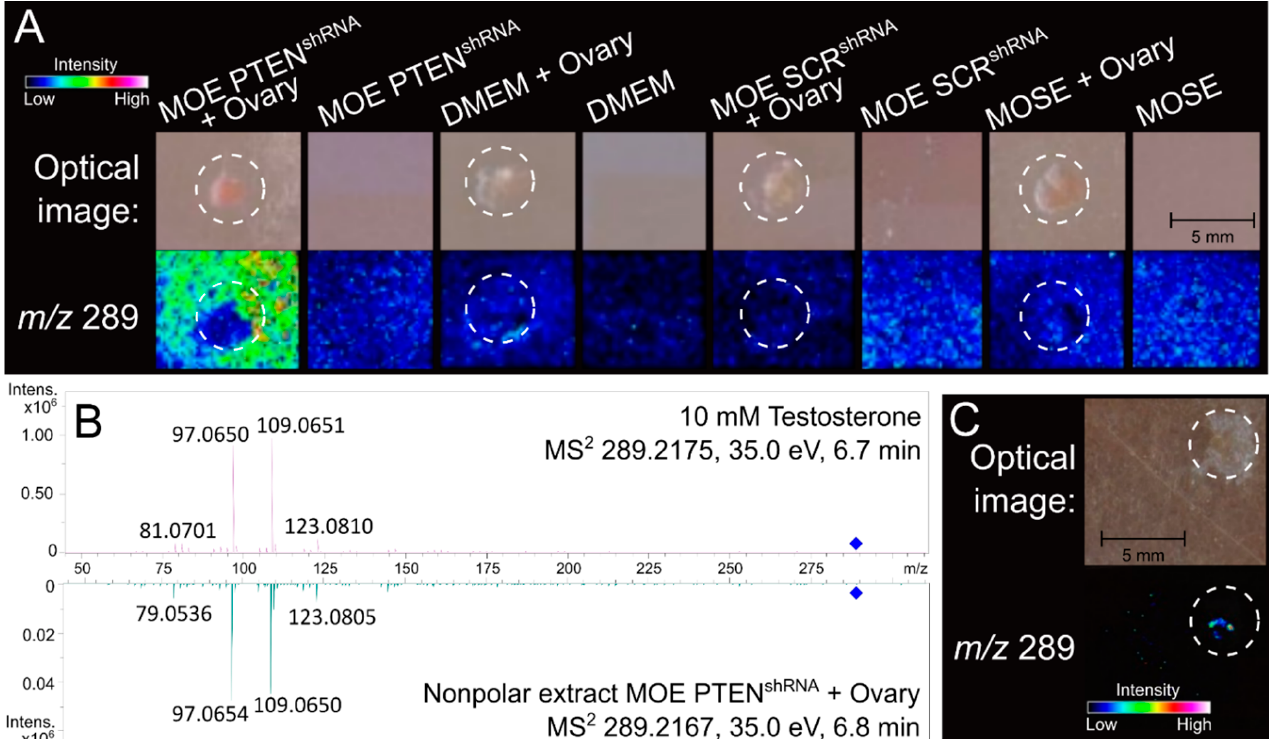
Figure 1. Tumor cells increase ovarian production of androgens. ( A ) A biomolecule upregulated in an in vitro tumorigenic condition may be testosterone. A validated imaging mass spectrometry sample preparation method was employed to detect increased production of small molecules (<2000 Da) in a condition of tumorigenic murine oviductal epithelial cells (MOE PTEN shRNA ) incubated with a healthy murine ovary, compared to seven controls. Signal detection (by nominal m/z ) was compared to MOE:SCR shRNA (MOE cells with a scrambled shRNA, used as a gene control), MOSE (murine ovarian surface epithelial cells, used as a cell control), and culture medium, DMEM. Each cell line was incubated for four days with and without an ovary (outlined by a dotted white circle). Resulting IMS data were normalized to the TIC and evaluated by the statistical software SCiLS to determine signals significantly more abundant ( p < 0.05) in the MOE PTEN shRNA + Ovary condition compared to all others. One resulting signal was m/z 289, which putatively matched the nominal mass of protonated testosterone (exact calculated mass, [M + H] + = m/z 289.2168). ( B ) Testosterone presence was validated using tandem mass spectrometry. Direct mass fragmentation comparison of a testosterone standard (T4, 10 mM) to an extract of the MOE PTEN shRNA + Ovary sample validated the identity of the m/z 289 in the IMS panel as testosterone. The standard (2.4 ppm error) and extracted testosterone (0.34 ppm error) shared four matching mass fragments, generating confidence as a Level One identification according to the Chemical Analysis Working Group (CAWG). ( C ) Testosterone is produced by the ovary. A divided chamber setup, previously discussed [32], was employed to determine the source of the testosterone production. Incubation conditions were identical and spatial orientation was tested with the MOE PTEN shRNA cell culture (bottom left half) distanced by ~2 mm from the ovary explant (top right), which was plated in media to maintain growth conditions. The m/z 289 was distinctly detected around the ovarian tissue, indicated that the ovary produces or releases testosterone when incubated in the presence of tumorigenic MOE cells.